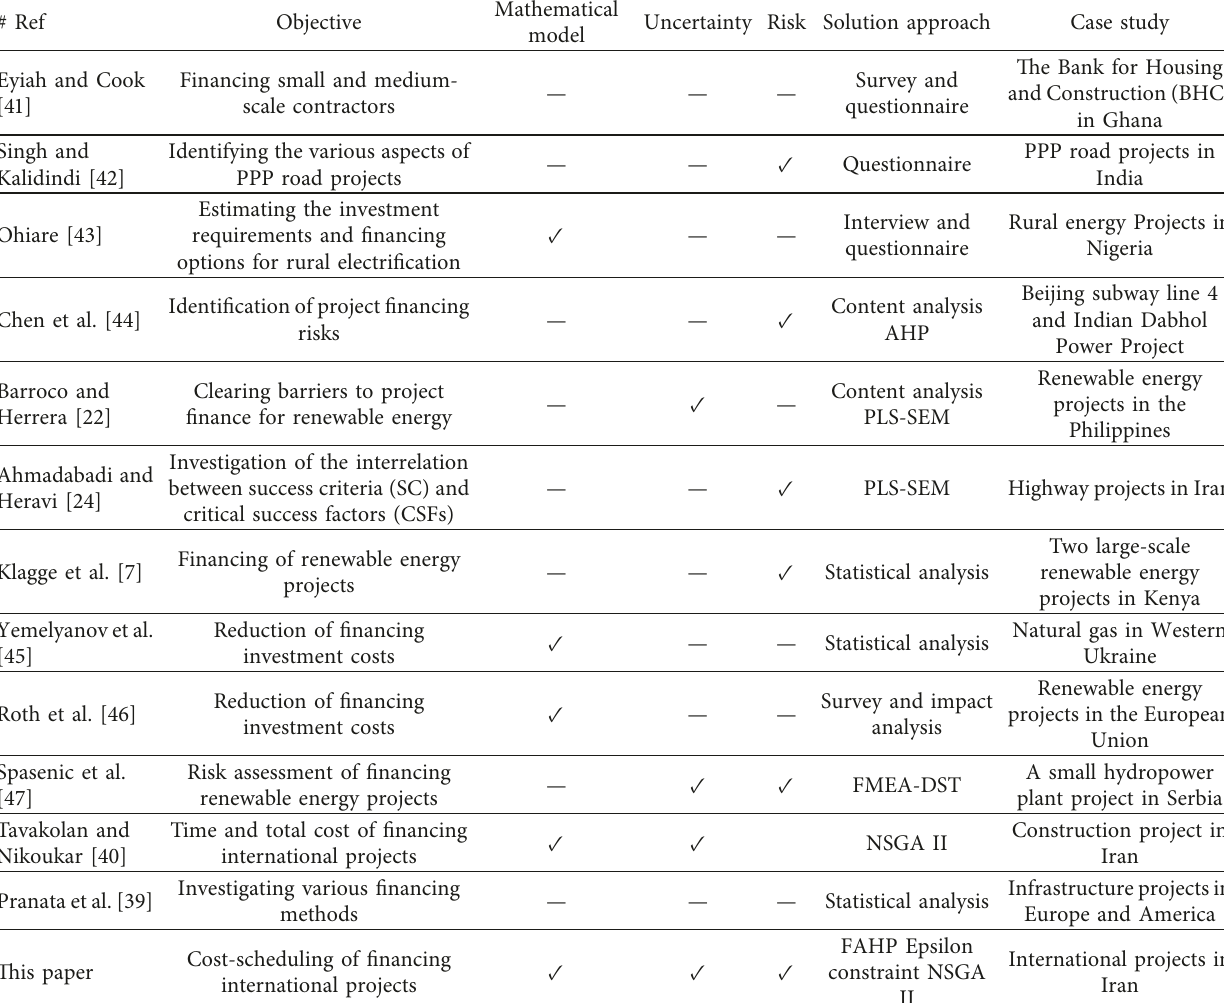
Table 1: Examining the research gap in the field of project